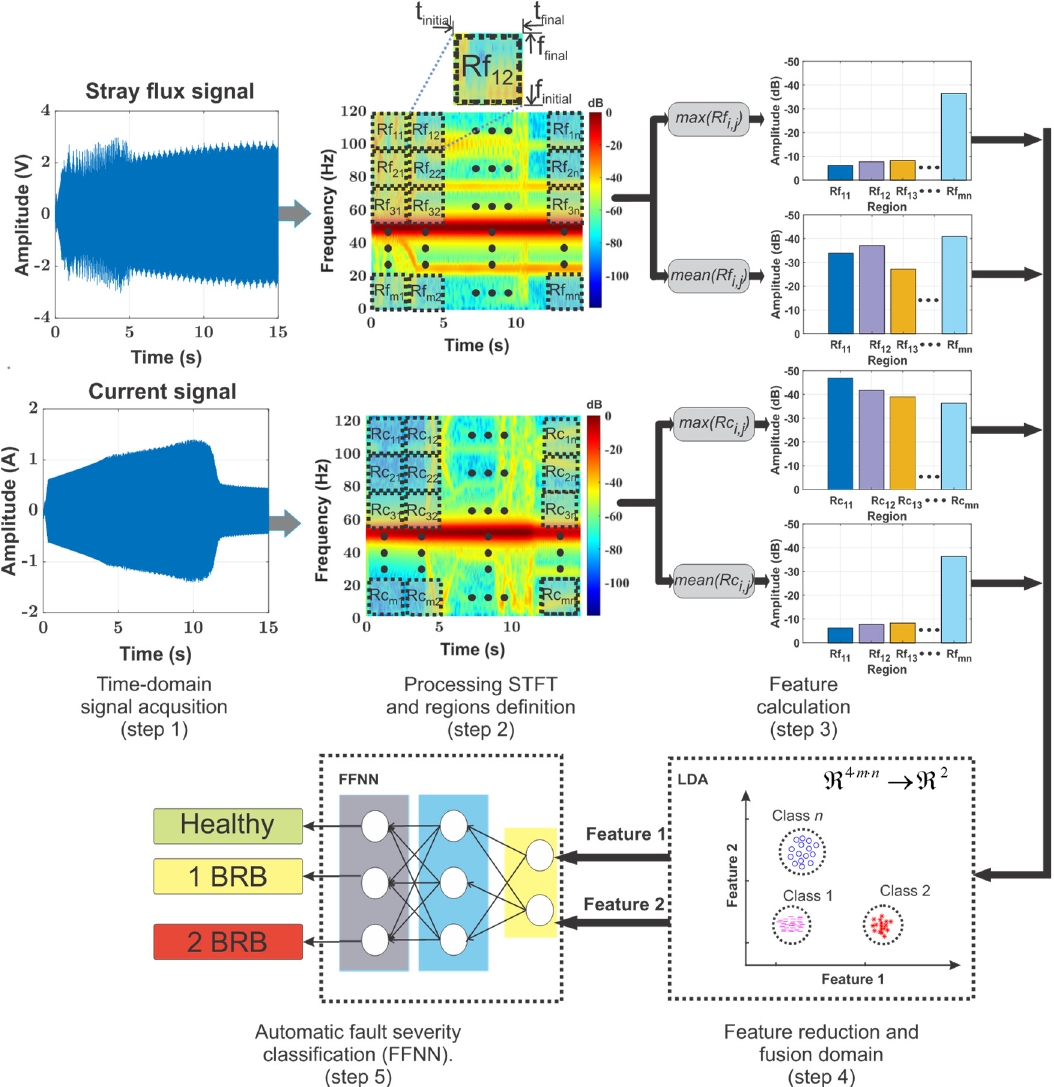
Figure 5. Proposed methodology flow-up.